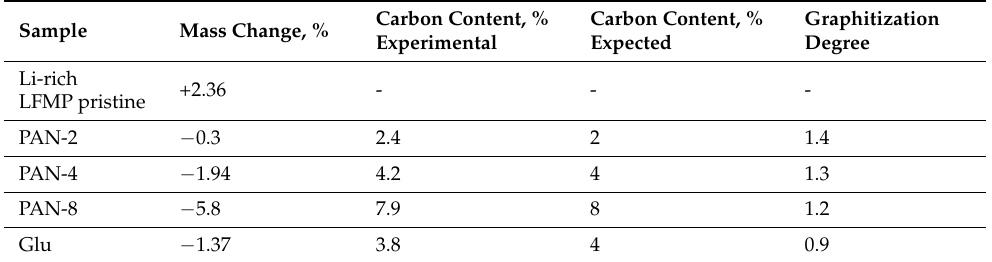
Table 2. Mass change and determined carbon content values for Glu and PAN samples.